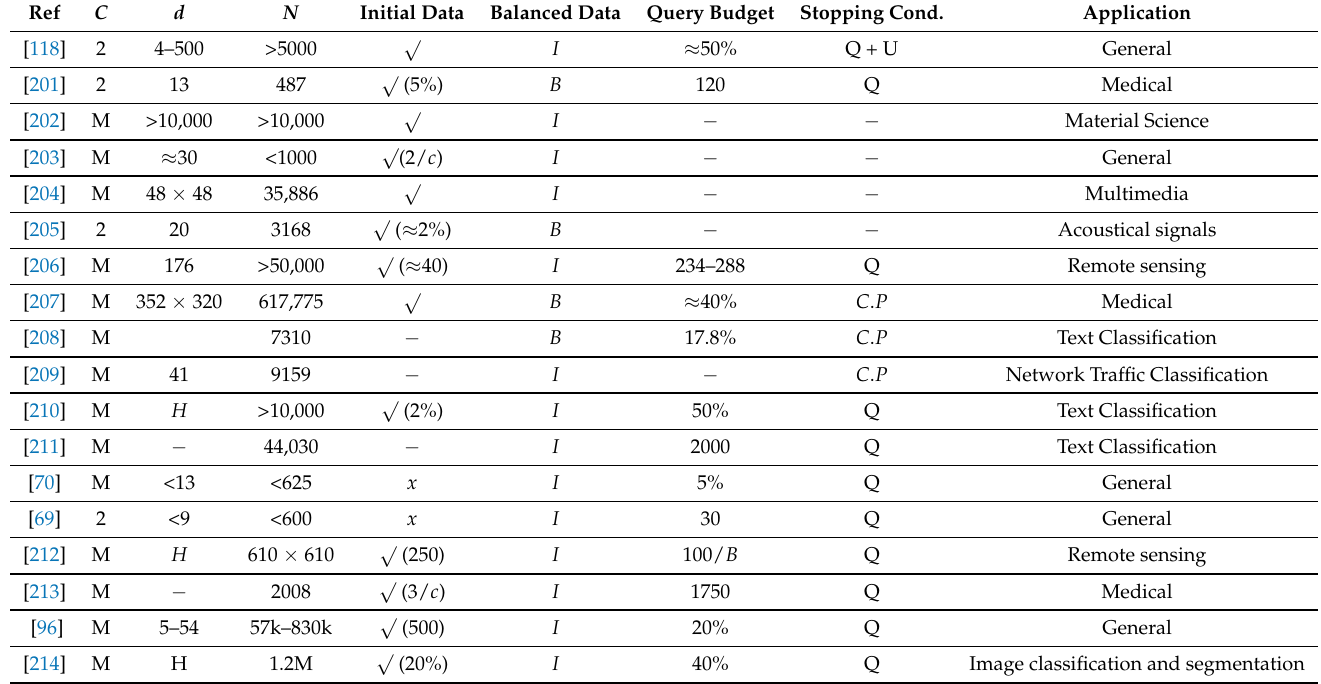
Table 2. Comparative summary of various recent AL algorithms in terms of dataset-related infor- mation (e.g., C , number of classes; d , number of dimensions; N , data size, balanced or imbalanced data), AL-related information (e.g., initial labeled data, query budget, and termination condition), and